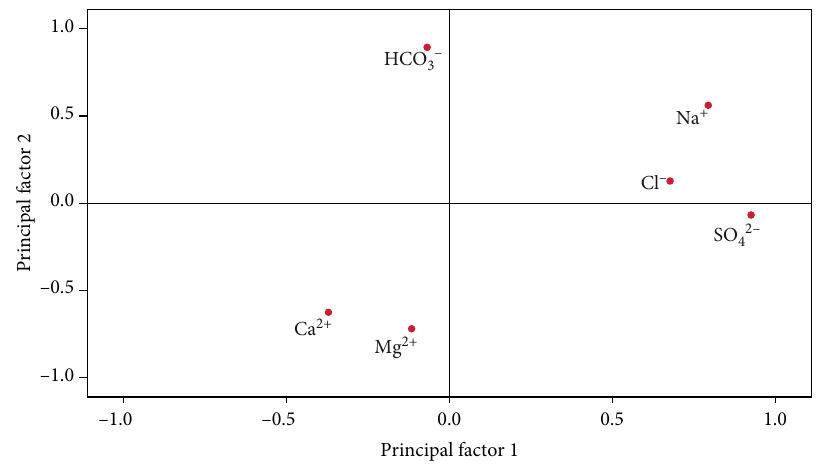
Figure 6: Load distribution of each parameter on the principal factor Z1 – Z2. Table 4: Principal factor score coe ffi cients.